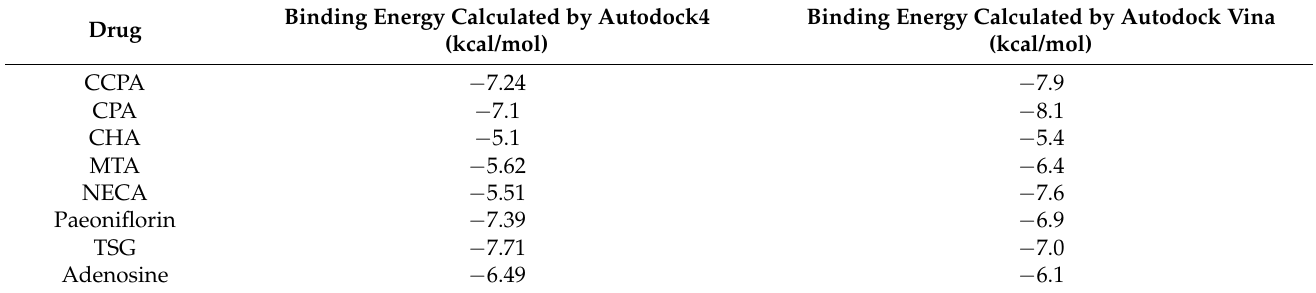
Table 2. Docking results with human A1R (PDB ID: